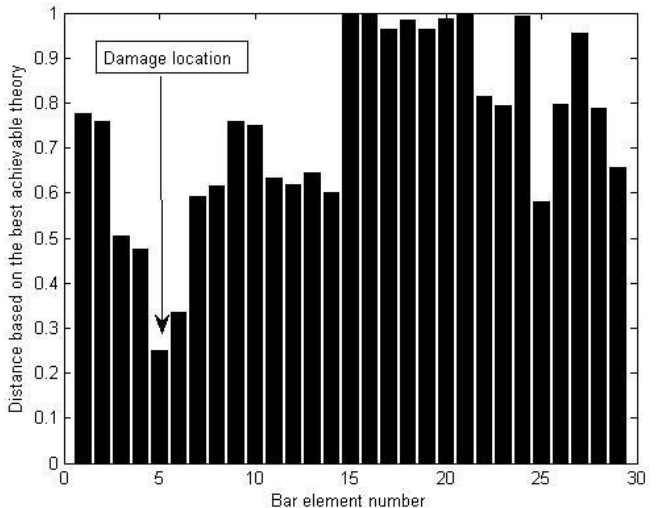
Figure 9. The distance δ (cid:48) for the experimental truss structure when bar element 5 is damaged.